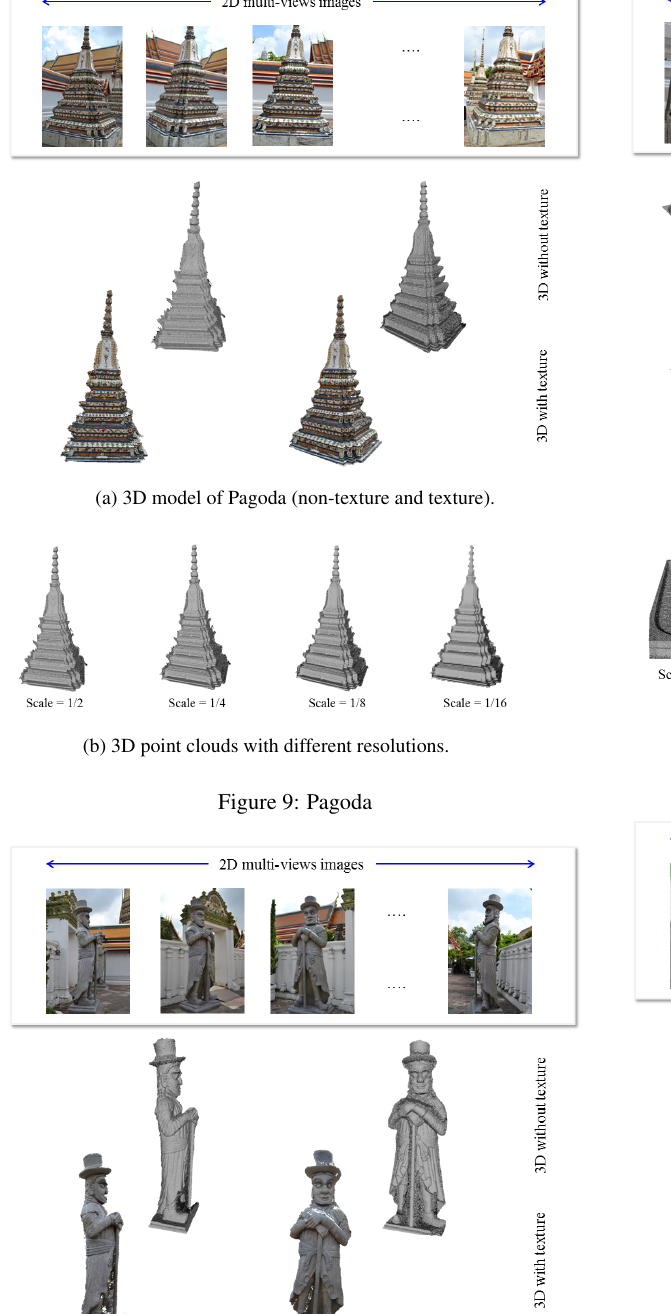
(a) 3D model of Rahoo sculpture (non-texture and texture).